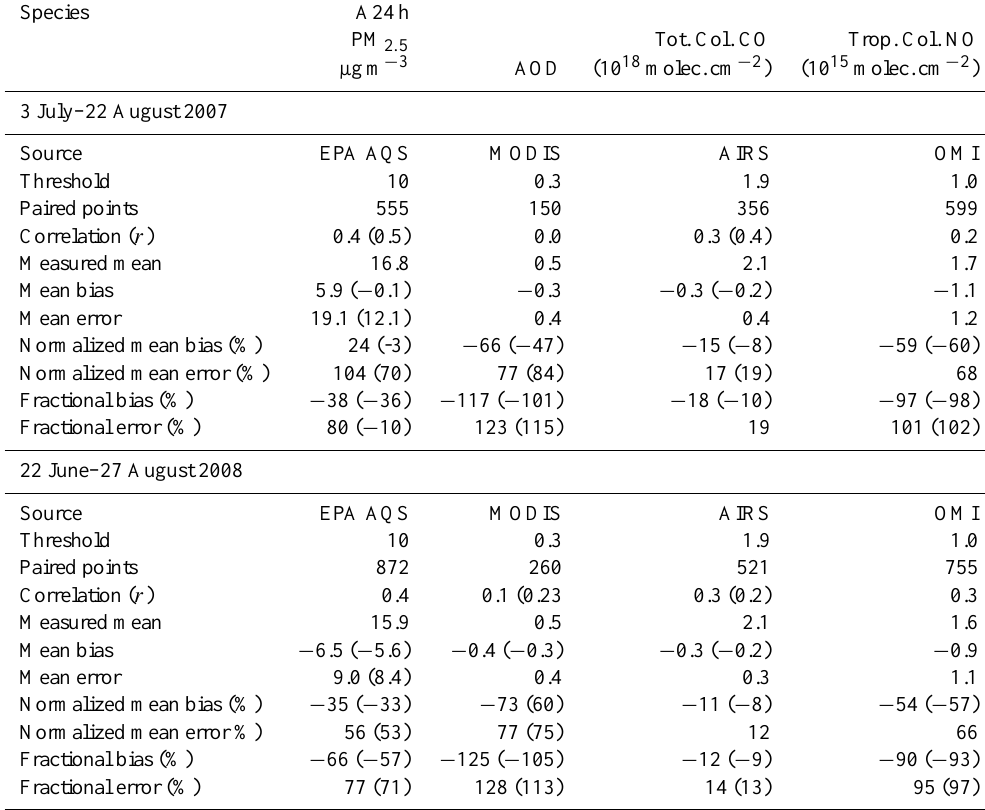
Table 4. Summary of FEPS plume-rise scenario matched threshold comparison (SMOKE plume-rise scenario shown in parentheses when different) from 3 July to 23 August 2007 (top) and 22 June to 27 August 2008 (bottom). “Matched Threshold” refers to both model and observation values being removed from the analysis if either is below the threshold in combination with satellite statistics using rural sites only.